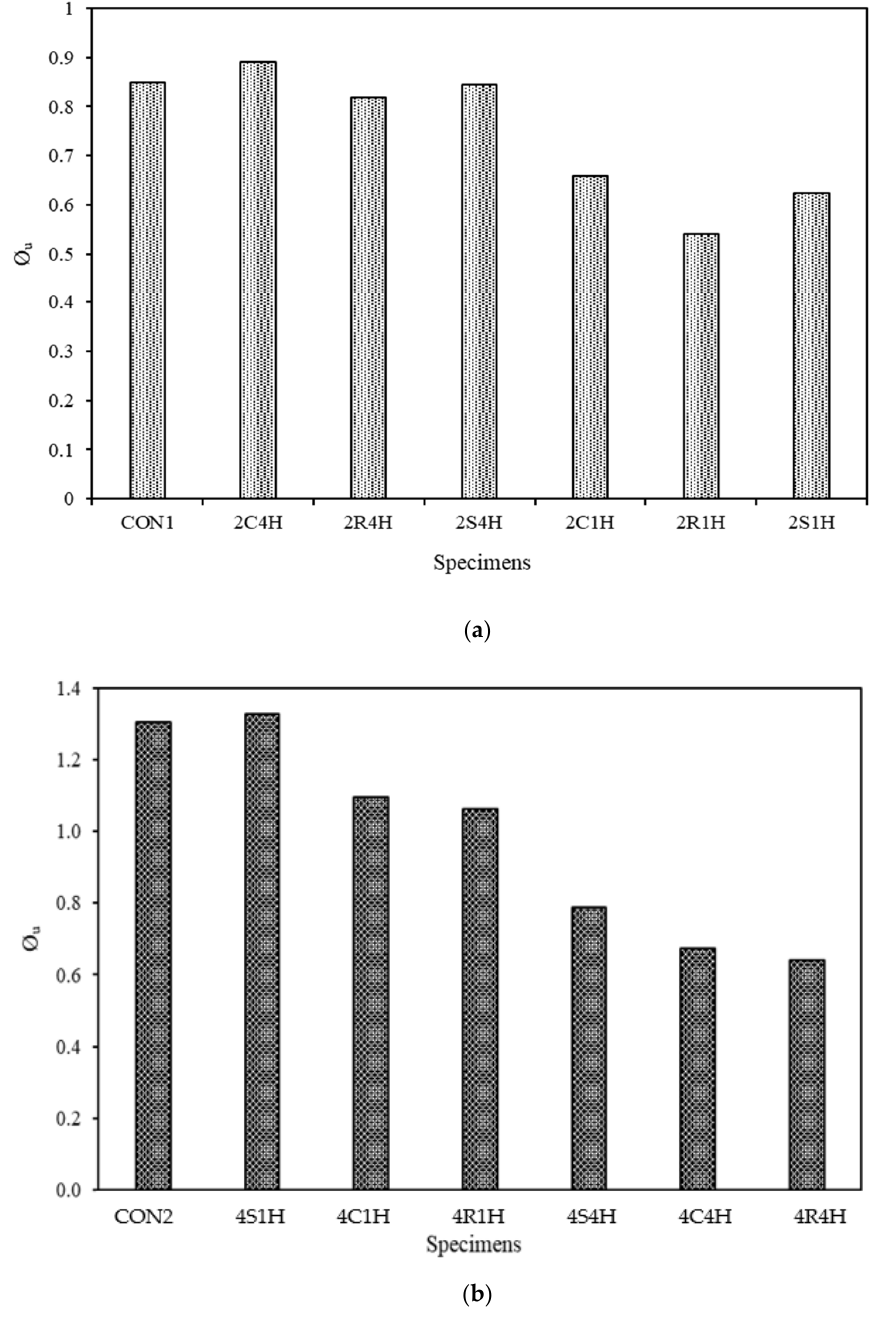
Figure 13. Ultimate rotations of slabs in ( a ) 2 openings ( b ) 4 openings.